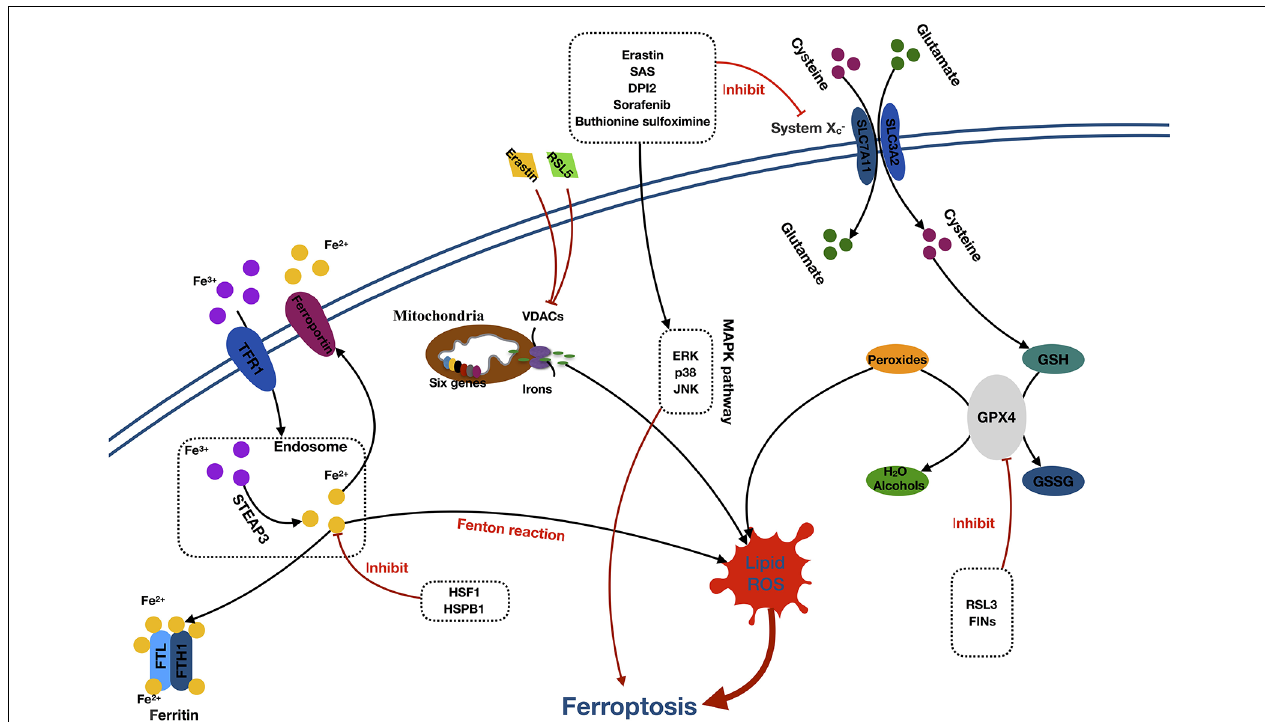
FIGURE 2 | Mechanisms of ferroptosis. Abbreviations: TFR1, transferrin receptor 1; STEAP3, six-transmembrane epithelial antigen of prostate 3; FTL, ferritin light chain; FTH1, ferritin heavy chain 1; HSF1, heat shock factor 1; HSPB1, (HSF1)-heat-shock protein B1; RSL5, Ras selective lethal 5; VDACs, voltage-dependent anion channels; SAS, sulfasalazine; DPI2, diphenyleneiodonium 2; ERK, extracellular signal–regulated kinase; JNK, c-jun–N-terminal kinase; MAPK pathway, mitogen-activated protein kinase pathway; SLC7A11, solute carrier family 7 member 11; SLC3A2, solute carrier family 3 member 2; GSH, glutathione; GPX4, glutathione peroxidase 4; GSSG, oxidized glutathione; RL3, ribonuclease 1; FINS, fasting serum